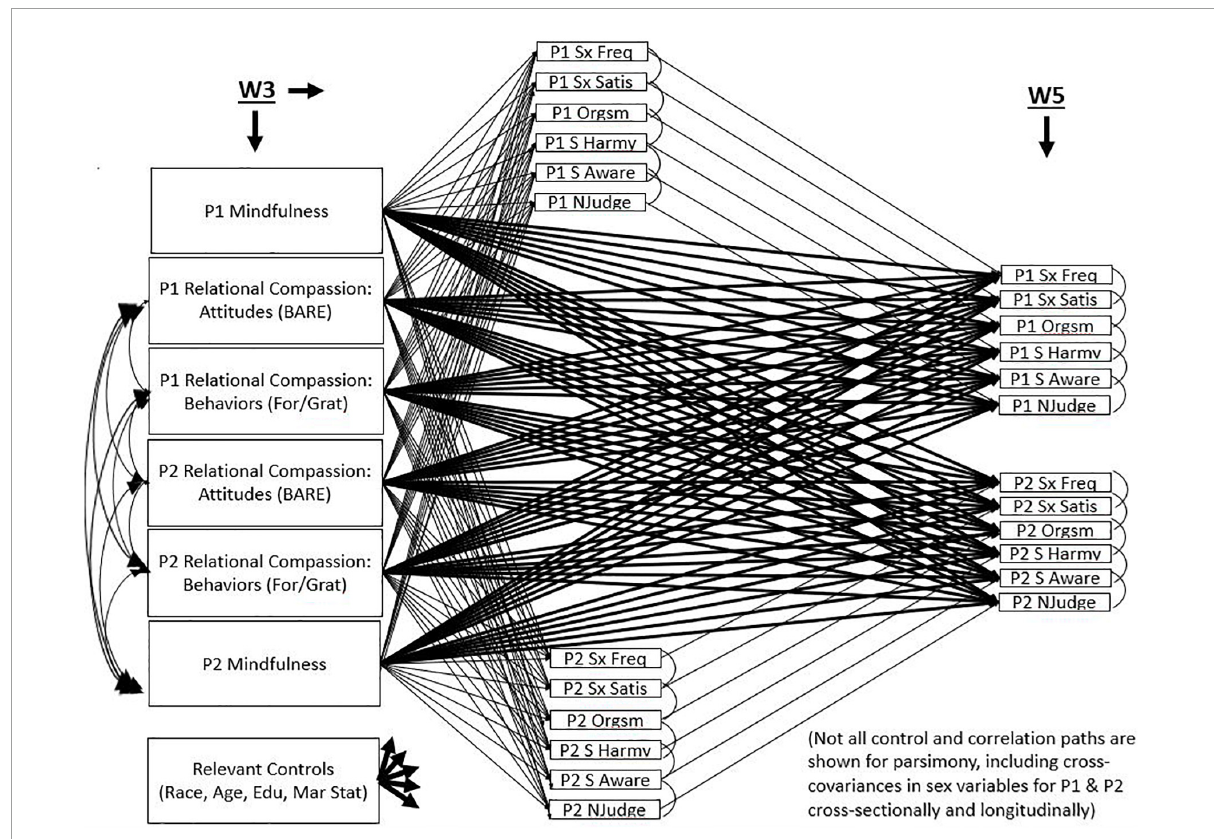
FIGURE1 Longitudinal actor partner interdependent model showing cross-sectional and longitudinal relations between elements of relational compassion and sexual wellbeing across two years.